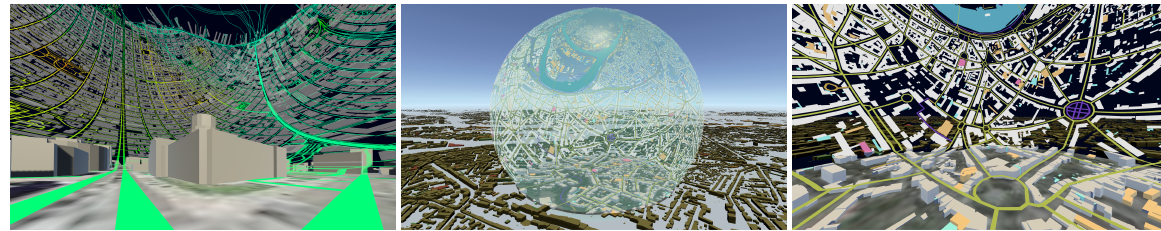
Figure 4. Different configurations of the data sphere (middle) for urban focus+context multiviews (left and right) the sphere accordingly, ensuring a consistent projection in all directions and at all